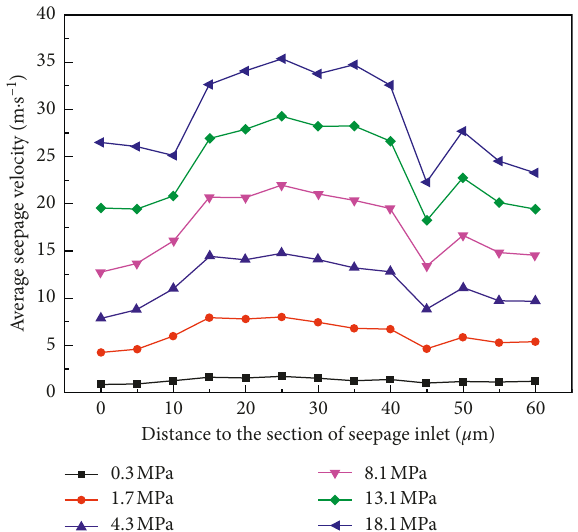
Figure 17: Variations of average velocity with seepage length under different inlet